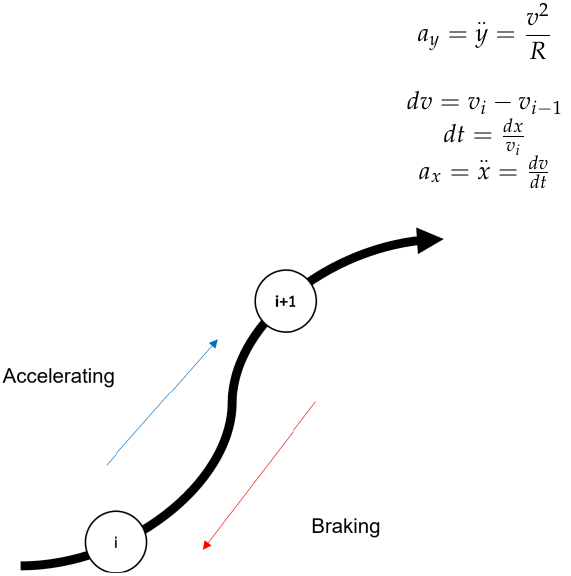
Figure 12. Illustration of quasi-steady-state simulation.